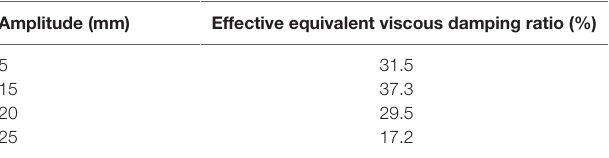
TaBle 1 | effective equivalent viscous damping ratios under 0.5 hz frequency and different amplitudes of the sinusoidal excitation. amplitude (mm) effective equivalent viscous damping ratio (%)